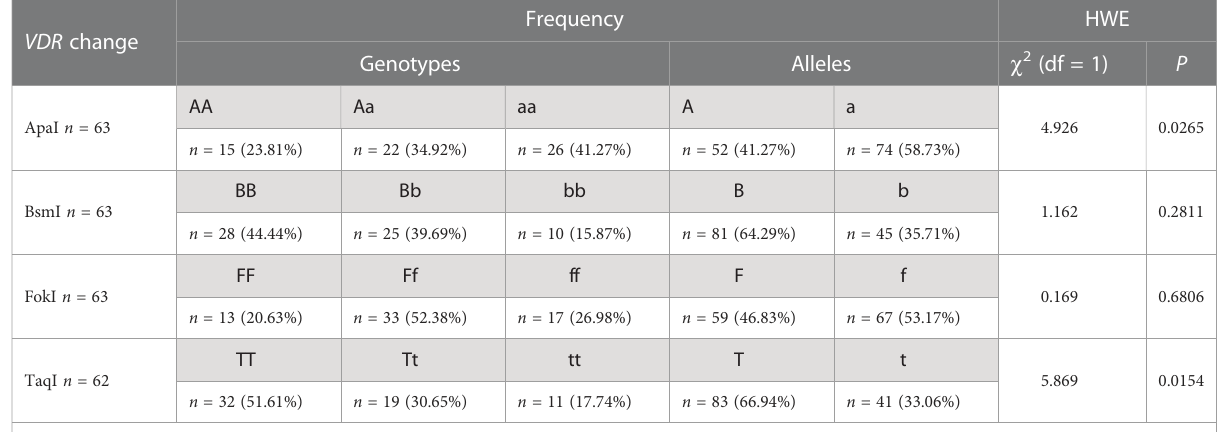
TABLE 1 Allele and genotype distribution for the ApaI , BsmI , FokI and TaqI polymorphisms of the VDR gene in the sample group.